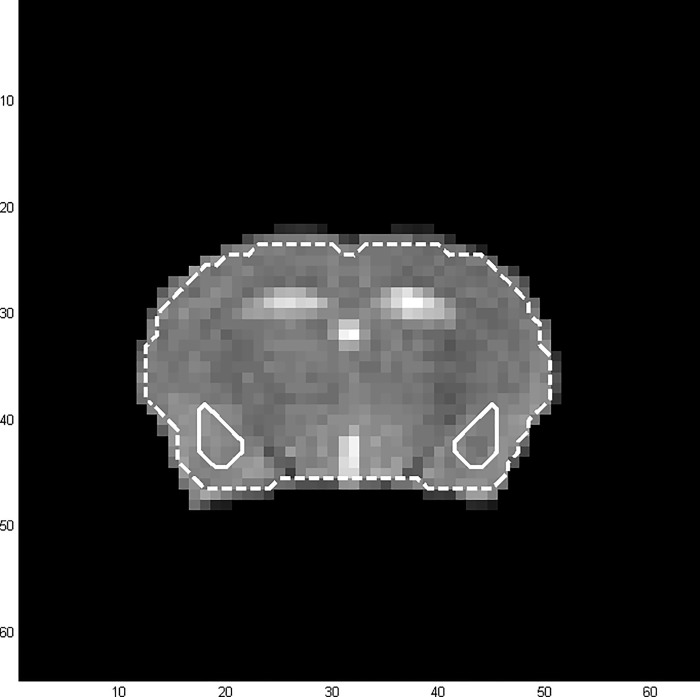
Consolidated mouse brain image with defined regions of interest.Total brain in dashed white lines and amygdala (comprising the lateral, basolateral and central amygdaloid nucleus) in solid white lines.